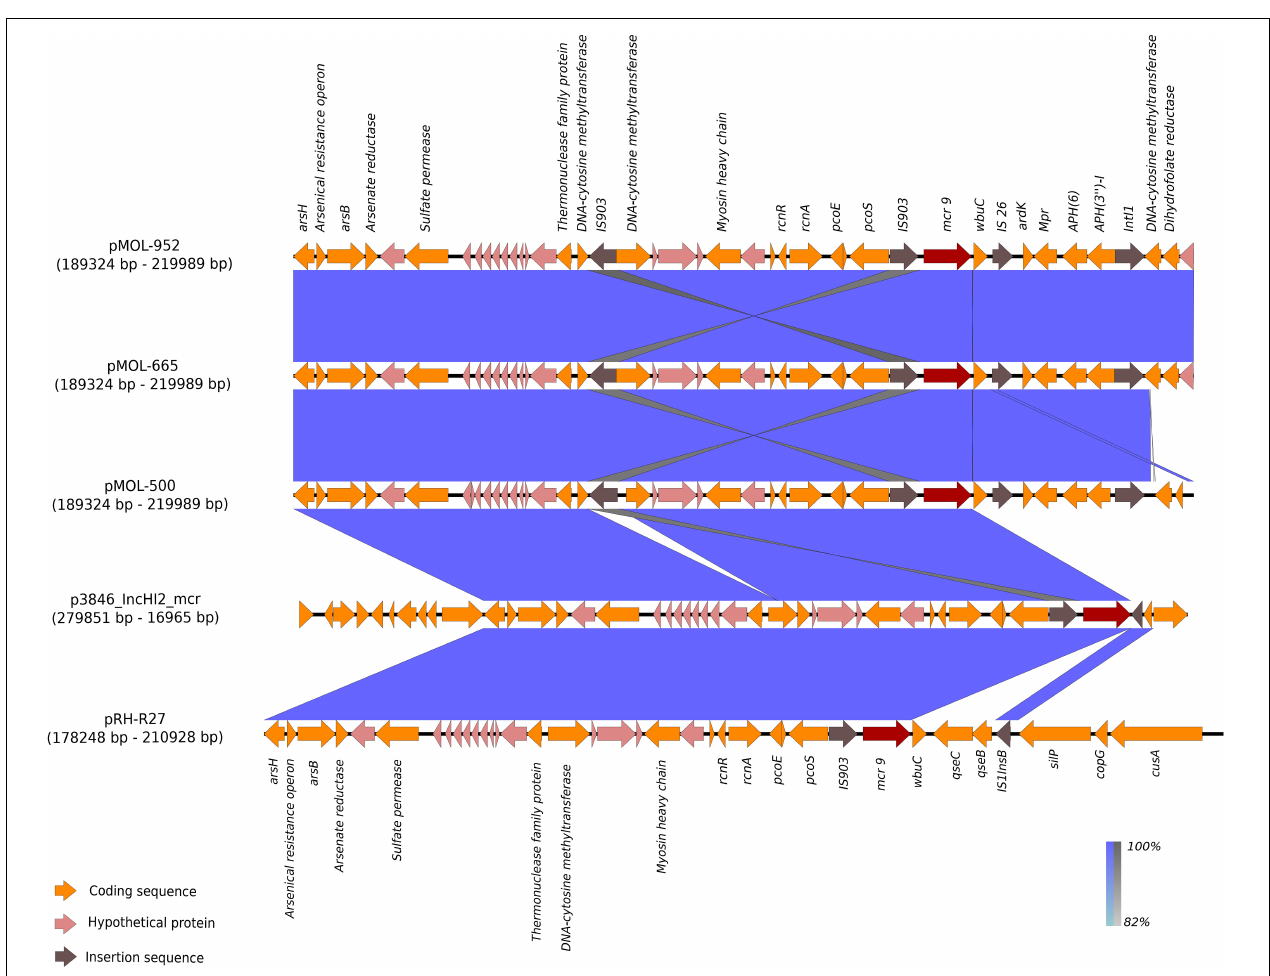
FIGURE 4 | BLAST graphical output of the region where mcr-9 is located in pMOL-952 (ERZ2110542), pMOL-665 (ERZ2110531), pMOL-500 (ERZ2110487), p3846_IncHI2 (CP052871), and pRH-R27 (LN555650.1). Red arrows: mcr-9 gene, orange arrows: Genes encoding functional proteins, pink arrows: Genes encoding hypothetical proteins, brown arrows: Mobile genetic